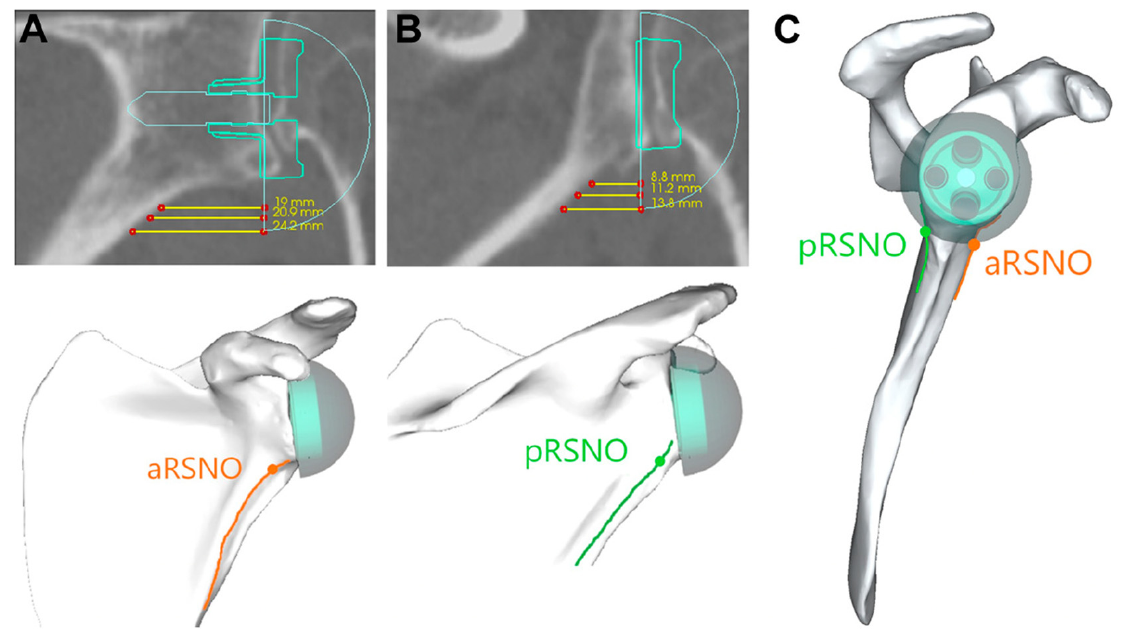
Figure 2. ( A ) Location of aRSNO in a sagittal view. ( B ) Location of pRSNO in a sagittal view. ( C ) Location of pRSNO and aRSNO in a coronal view. Figure reused with permission from the article of Bauer et al. [18]. aRSNO: anteroinferior relevant scapular neck offset; pRSNO: posteroinferior relevant scapular neck offset.